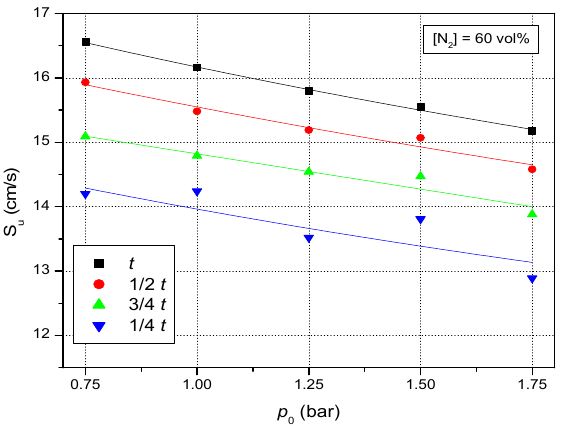
Figure 7. Variation of laminar burning velocities with initial pressure for stoichiometric CH 4 -N 2 O mixture, diluted with 60% N 2 , at room temperature.